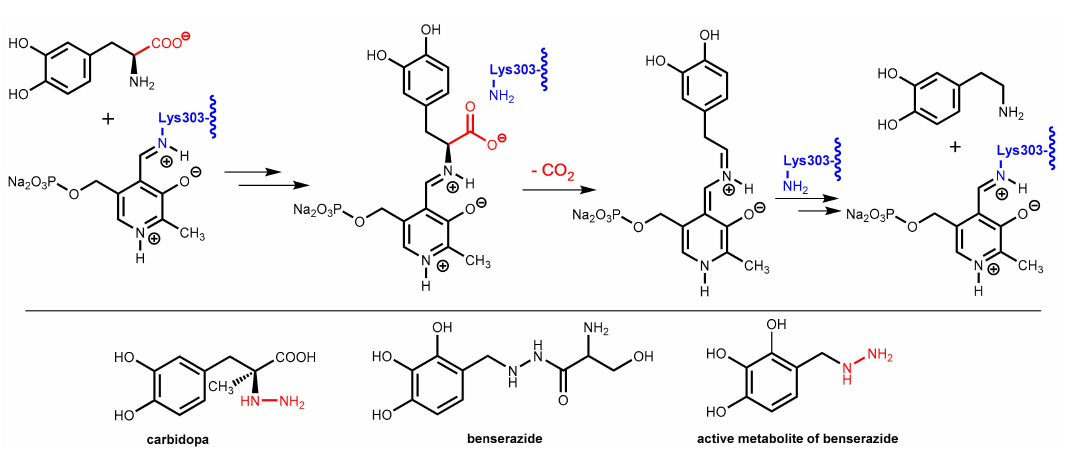
Figure 25. ( Top ): Molecular mechanism of the decarboxylation of levodopa by DOPA decarboxylase (relevant lysine residue highlighted in blue) aided by the co-factor pyridoxal phosphate. ( Bottom ): Structures of the DOPA decarboxylase inhibitors carbidopa, benserazide, and its active metabolite. The essential hydrazine moieties in the active inhibitors are highlighted in red.